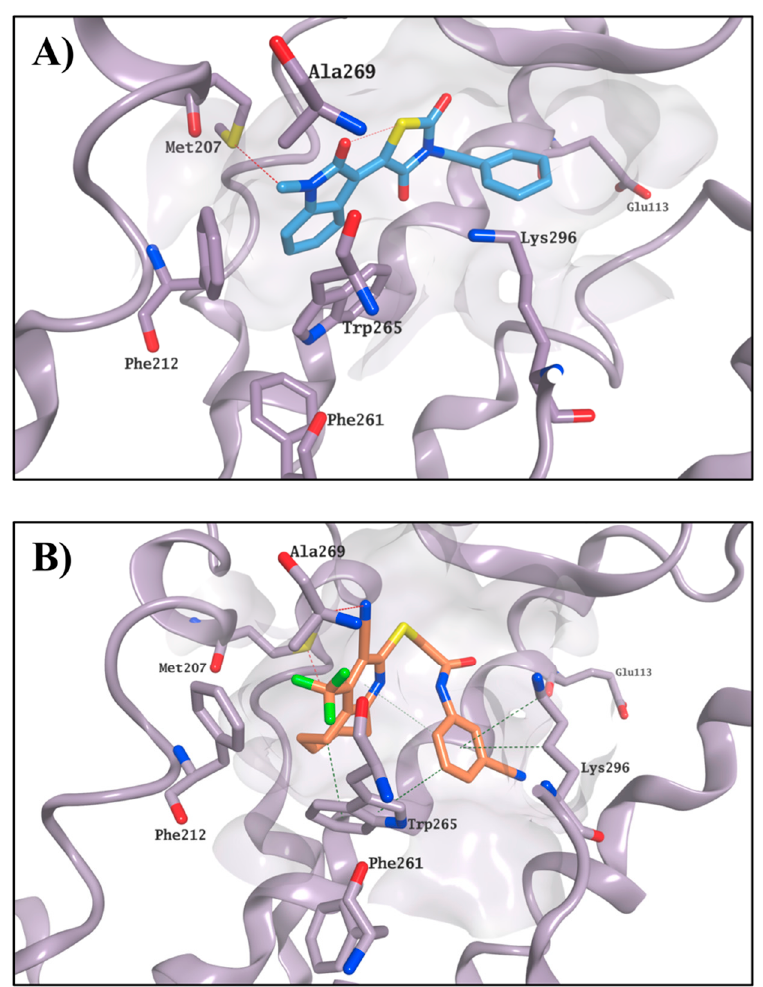
Figure 6. Binding mode for 20 (carbon atoms in cyan) ( A ) and 23 (carbon atoms in orange) ( B ) after MD simulation. The binding site area is represented as the molecular surface. Rhodopsin is represented as the lilac ribbon. Ribbon for residues 261–271 and 289–295 is hidden for clarity.